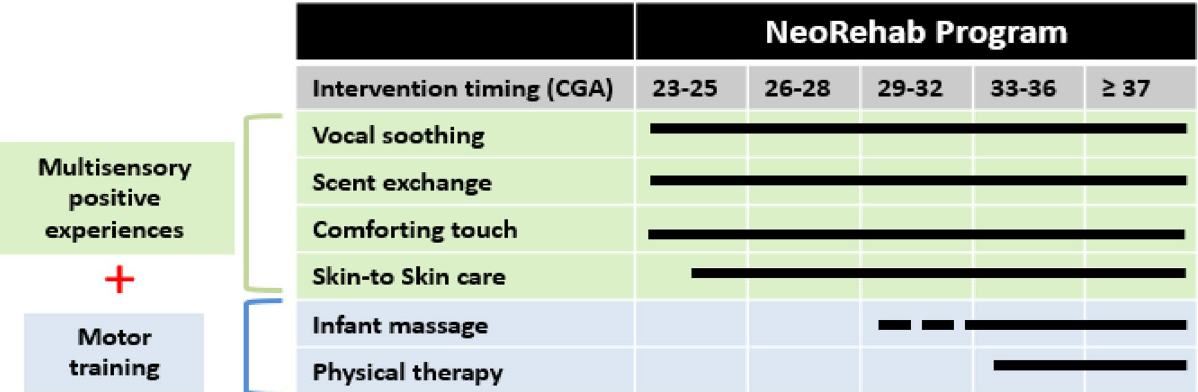
Figure 1. Description of the NeoRehab program. The NeoRehab program centered on 6-interventions (vocal soothing, scent exchange, comforting touch, kangaroo care, infant massage and physical therapy) that parents can provide shortly after birth and that are systematically layered considering the infant’s gestational age and physiologic stability, with increasingly complex motor interventions with advancing postnatal 10 min sessions twice a day, starting at 34 weeks PMA or when deemed clinically appropriate by PT 22 . These three